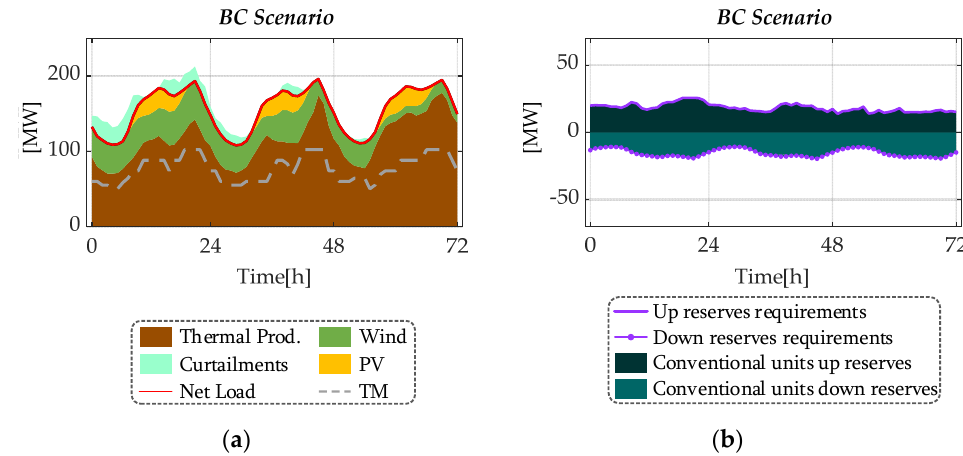
Figure 4. Base-case (BC) scenario without storage. ( a ) Generation mix and ( b ) provision of primary up/down reserves by conventional units over a three-day period.